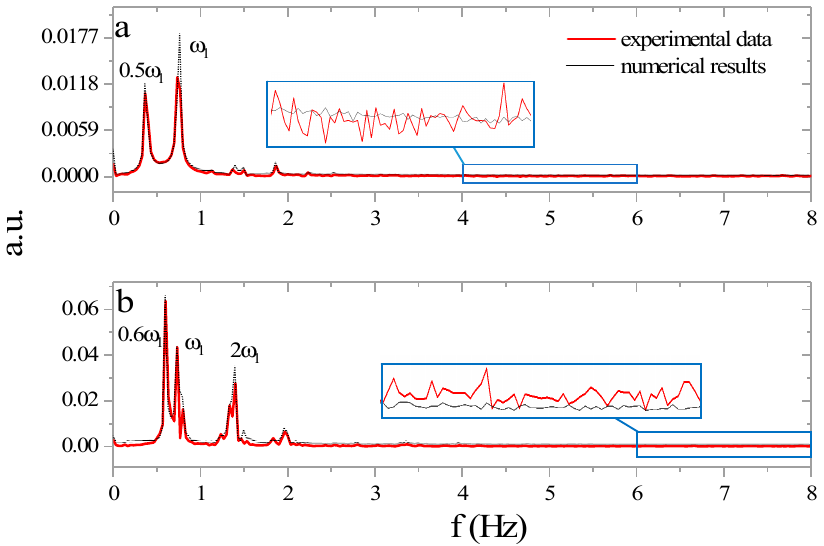
Figure 7. The Fast Fourier Transformation of the time history of the experimental and numerical pressure (amplitude is 7 mm, h = 90 mm, ω a = 0.5 ω 1 , ω b = 0.8 ω 1